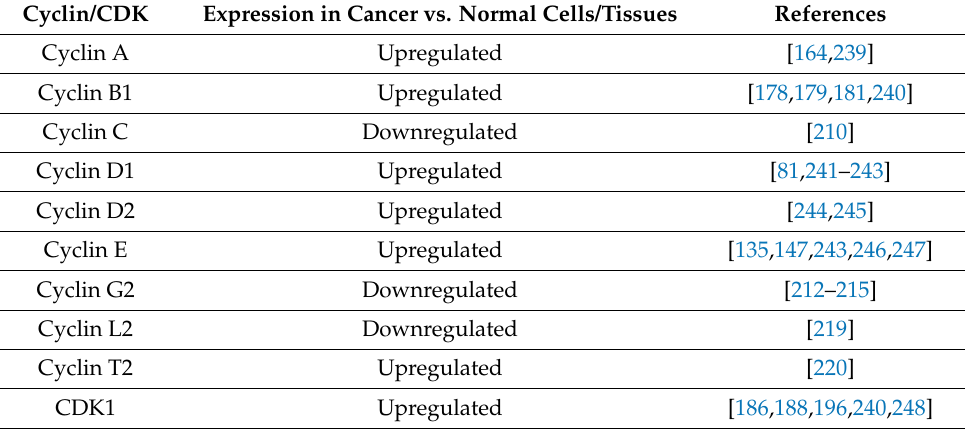
Table 9. The levels of Cyclins and CDKs alter upon Tumorigenesis. The upregulation or down- regulation of all Cyclins and CDKs investigated in gastric cancer tissues or cells compared to their normal counterparts. Cyclin/CDK Expression in Cancer vs. Normal